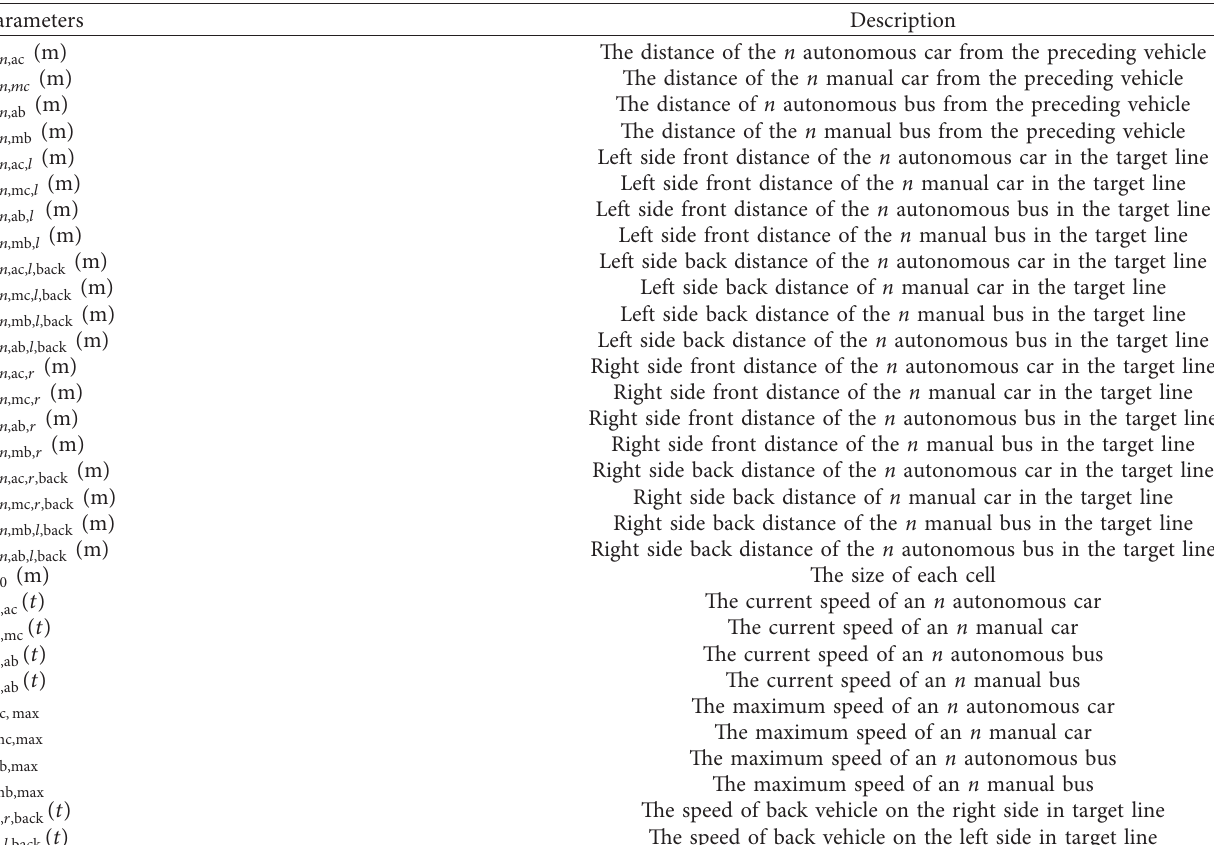
Table 1: Parameters in the model.